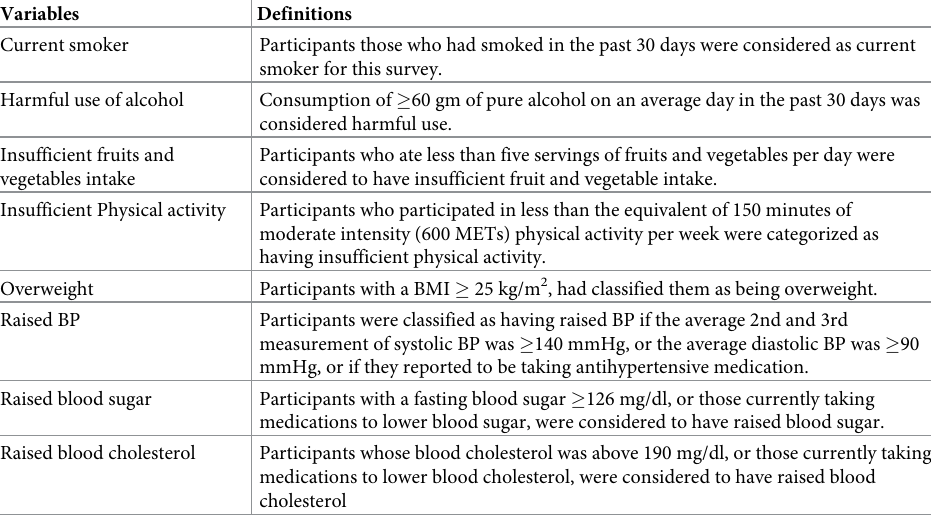
Table 1. Variables